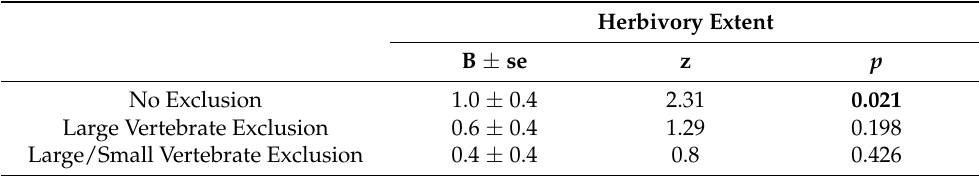
Table 3. Contrasts (B) * of each exclusion treatment relative to the full exclusion treatment on herbivory extent observed on poison ivy ( Toxicodendron radicans ) plants in year two of the herbivore exclusion experiment (z is the test